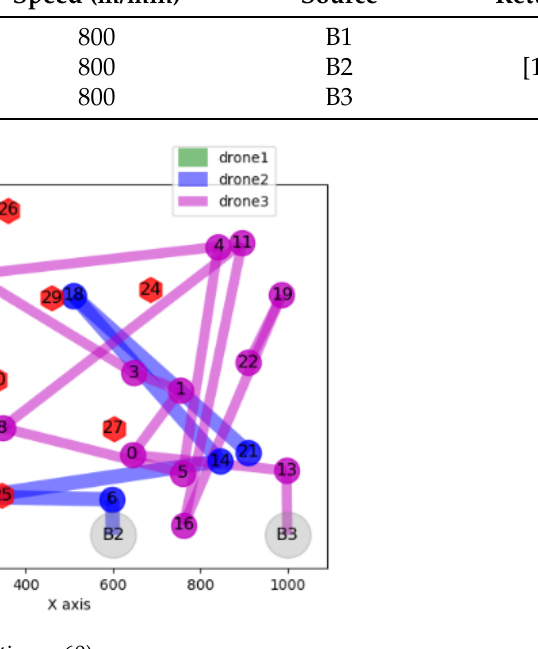
Figure 11. Path details (waiting = 60). Table 6. Data delivery when UAVs may be late for no more than 60 min.